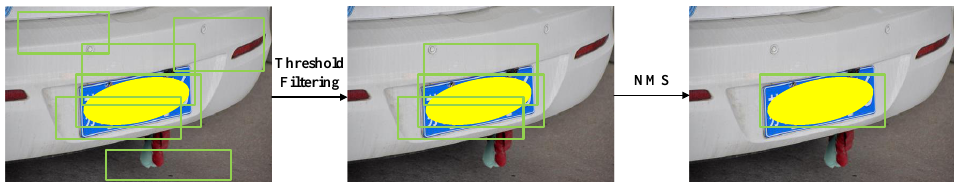
Figure 5. Post-processing operations. The green rectangles are the possible detection results predicted by the network. After threshold filtering and non-maximum suppression (NMS), we can get the final detection results. The license plate is manually covered with a yellow ellipsoid to protect